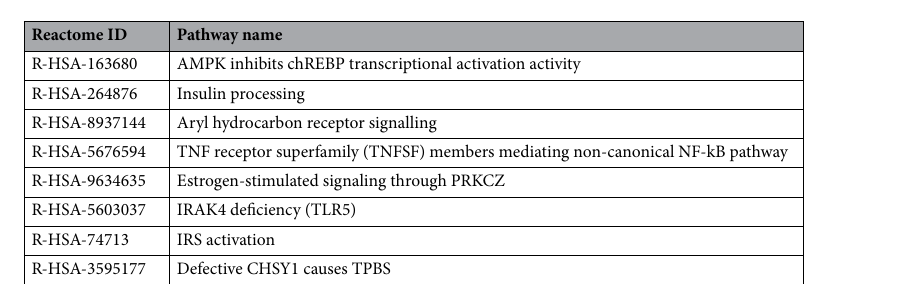
Table 3. The pathways with the highest magnitude SVM weights summed over all experiments and times. CPE configurations are pre-computed, directed edges with PageRank centrality. All experiments apply LIMMA using subject identifier to the